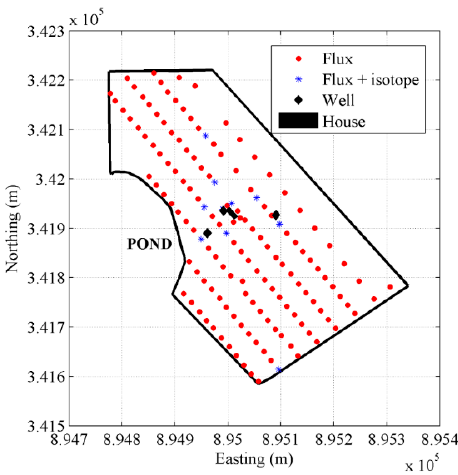
Figure 1. Hudson site showing flux and isotope sampling locations. All coordinates are in Indiana State plane coordinates.